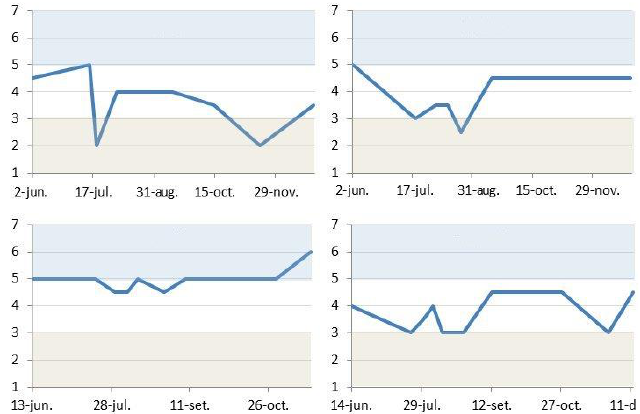
Figure 7. Hydrological temporal variation of four representative streams inhabited by C. arnoldi . Values of Y-axis: 1: dried; 2: Hiporheic; 3: arheic; 4; oligorheic whith streaches whith only subterranean running water; 5: oligorheic; 6: eurheic; 7: hiperrheic. Modified from [32].